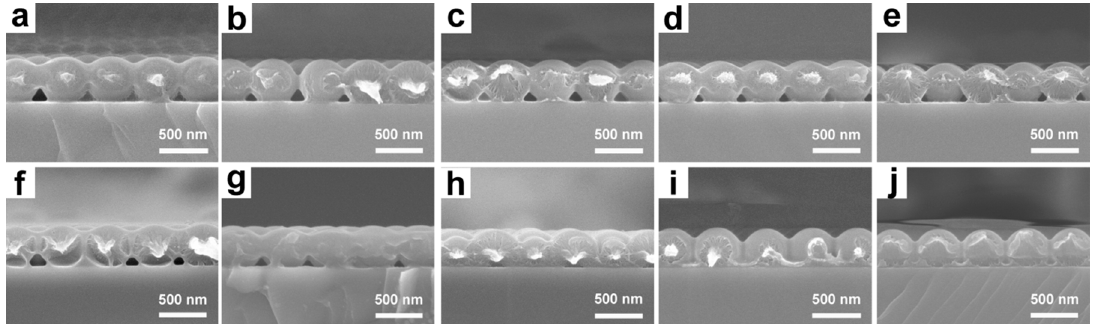
Figure 2. SEM images of the fabricated structures: ( a – e ) cross-sectional views of the qP2VP-infiltrated ncp MCCs-x (x = ( a ) 0 min; ( b ) 2 min; ( c ) 4 min; ( d ) 6 min; and ( e ) 8 min); and ( f – j ) cross-sectional views of UPPGF-x (x = ( f ) 0 min; ( g ) 2 min; ( h ) 4 min; ( i ) 6 min; and ( j ) 8 min) obtained after thermal annealing.